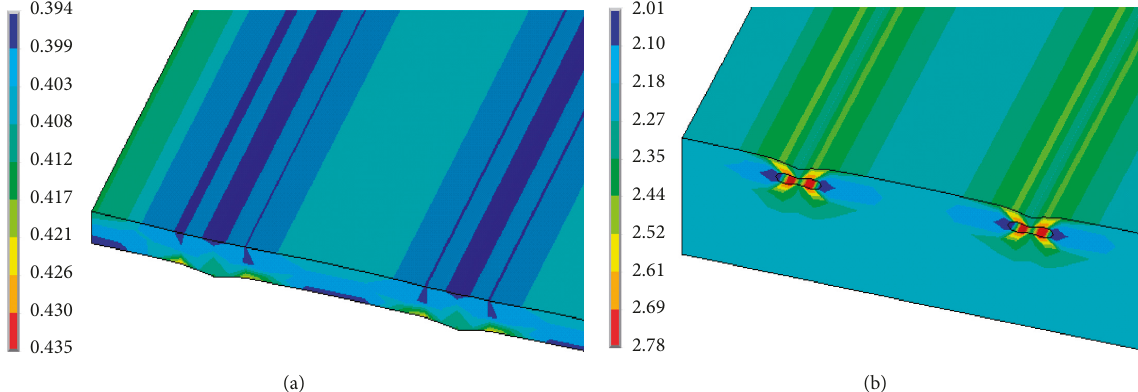
Figure 14: Maximum principle stress distribution (MPa) of HSMP under ambient temperature loads: (a) AL; (b) CL.